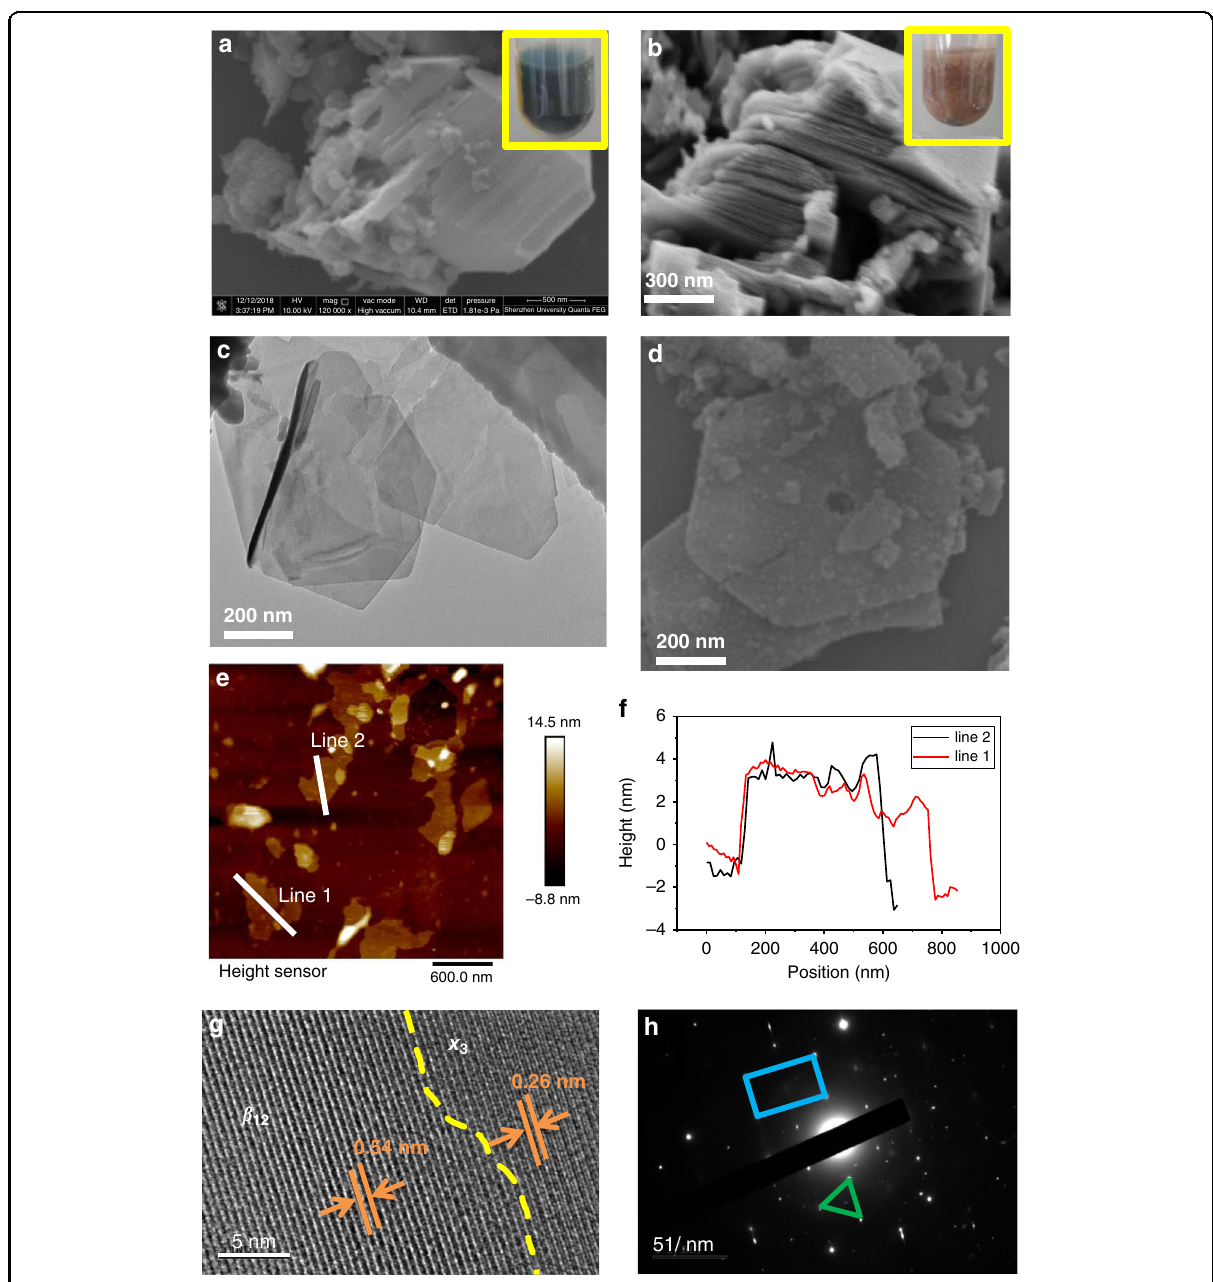
Fig. 3 Characterizations of the newly fabricated borophene. a Scanning electron microscope (SEM) image of bulk AlB 2 . Inset shows the black color of bulk AlB 2 before etching. b Book page-like morphology after HCl etching. Inset shows the red color of etching products from AlB 2 . c , d Transmission electron microscope (TEM) and SEM image of the borophene nanosheets. e , f The ultrathin thickness of borophene nanosheets characterized by atomic force microscope (AFM). g Crystal lattice characterized by the high-resolution TEM. h Selected-area electron diffraction (SAED) of borophene. The blue rectangle and green triangle correspond to the β 12 structure and χ 3 structure,